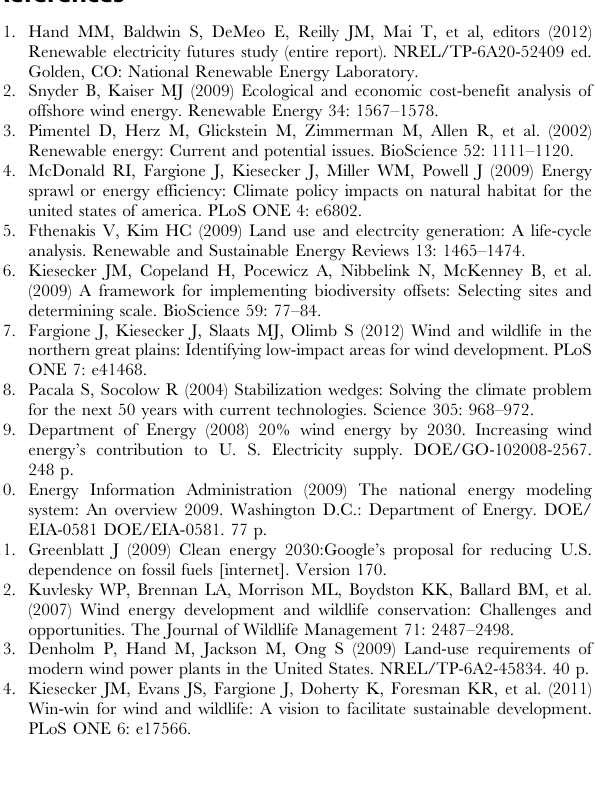
Table S3 Model results for land transformation at the facility scale. Sum of AICc weights are: Land cover =0.99, Topography = 0.05, Turbine size = 0.56, Configuration = 0.11. Table S4 Model results for the mean nearest neighbor distance between turbines. Sum of AICc weights are: Land